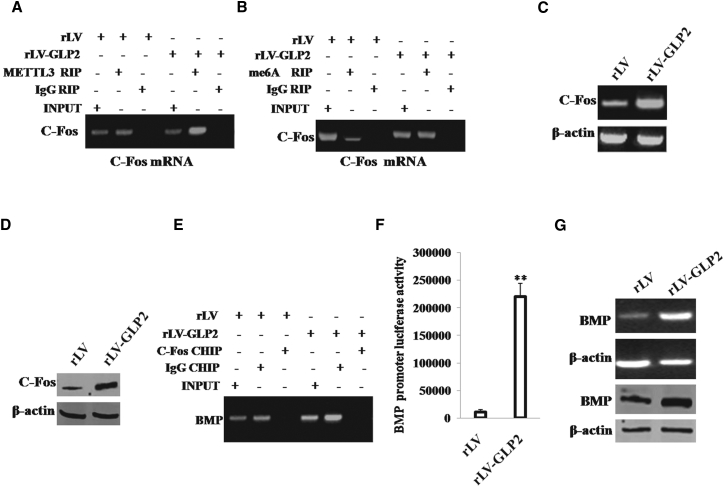
GLP2 Promotes the Expression of BMP Dependent on c-Fos(A) RNA immunoprecipitation (RIP) with anti-METTL3 followed by RT-PCR with c-Fos primers in OB cells induced from MG63 infected with rLV-GLP2 or rLV, respectively. IgG RIP as negative control. RT-PCR for c-Fos as INPUT. (B) RNA Immunoprecipitation(RIP) with anti-m6A followed by RT-PCR with c-Fos primers in OB cells induced from MG63 infected with rLV-GLP2 or rLV, respectively. IgG RIP as negative control. RT-PCR for c-Fos as INPUT. (C) RT-PCR analysis of Fos in OB cells induced from MG63 infected with rLV-GLP2 or rLV, respectively. β-actin as internal control. (D) Western blotting with anti-FOS in OB cells induced from MG63 infected with rLV-GLP2 or rLV, respectively. β-actin was used as an internal control. (E) ChIP assay with anti-FOS followed by PCR with DNA primers of BMP in OB cells induced from MG63 infected with rLV-GLP2 or rLV, respectively. IgG ChIP was the negative control. (F) The assay of luciferase activity of promoter of BMP in OB induced from MG63 infected with rLV-GLP2 or rLV, respectively. **p < 0.01. (G) Western blotting with anti-BMP and RT-PCR with BMP cDNA primers in OB cells induced from MG63 infected with rLV-GLP2 or rLV, respectively. β-actin as internal control.